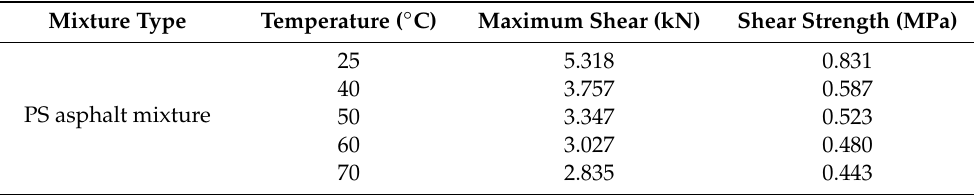
Table 6. Results of interlaminar shear tests at di ff erent temperatures.